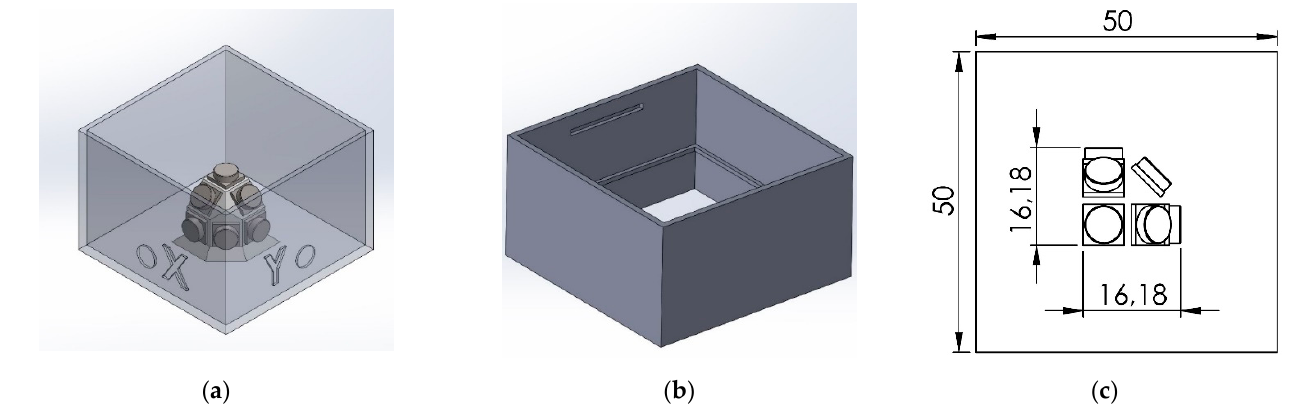
Figure 3. Casting molds: ( a ) Lower mold with the positive print used to create the cavity for the sensor positioning, marks are printed to the surfaces to indicate the sensor position and identify the cube axes. ( b ) Upper mold used to complete the cube, marks on the surfaces allow for alignment of the mold over the first half of rubber specimen. ( c ) Position and size of the stress probe inside the testing specimen, the volume occupied by the actual sensing probe is confined to a cube of 17 mm side.